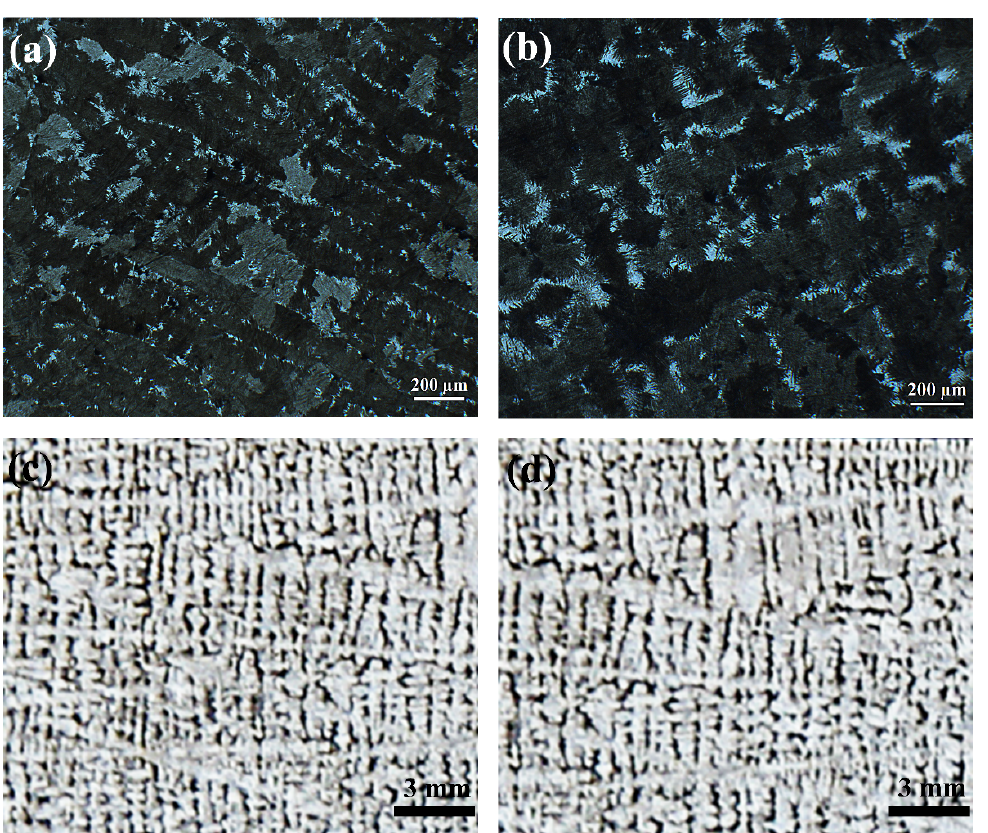
Figure 9. Dendritic microstructure from surface to center in bloom cross-section for S-4 and S-5, ( a ) S-4, 10 mm, ( b ) S-4, 40 mm, ( c ) S-5, 100 mm, ( d ) S-5, 120 mm.